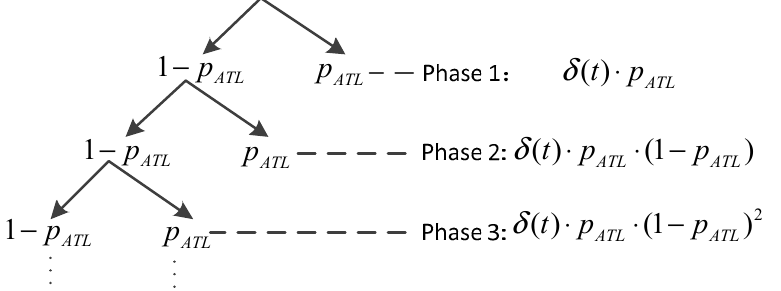
Figure 5. Probabilistic distribution density tree of Adaptive Traffic Load Contention Resolution Diversity Slotted ALOHA (ATL-CRDSA).